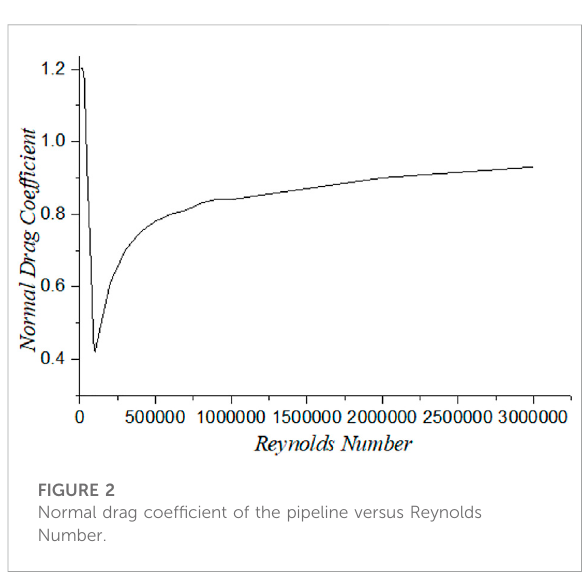
FIGURE 2 Normal drag coef fi cient of the pipeline versus Reynolds Number.